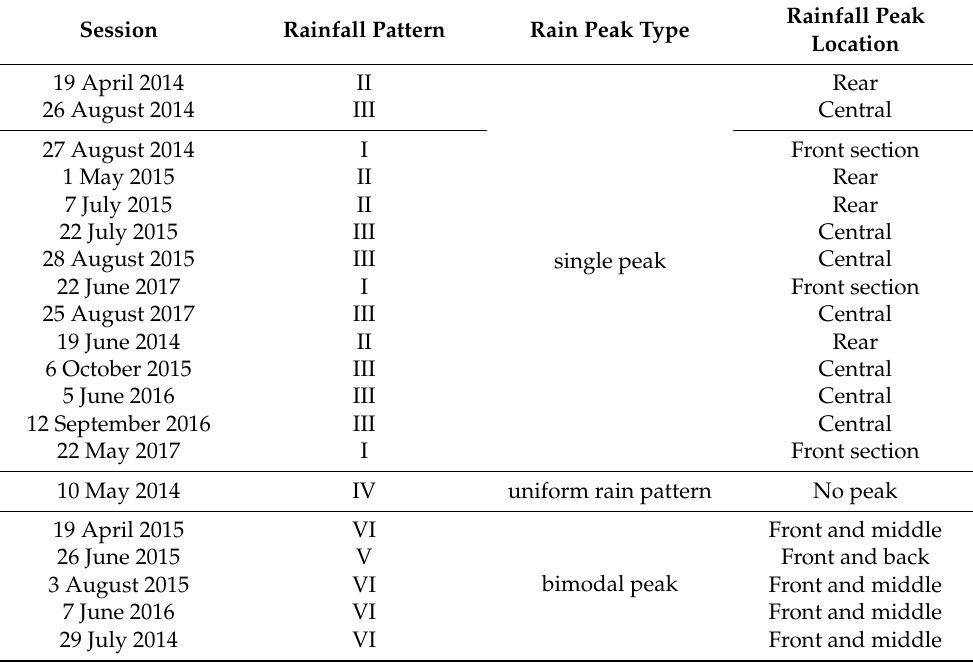
Table 5. Identified rainfall pattern results from the measured data.